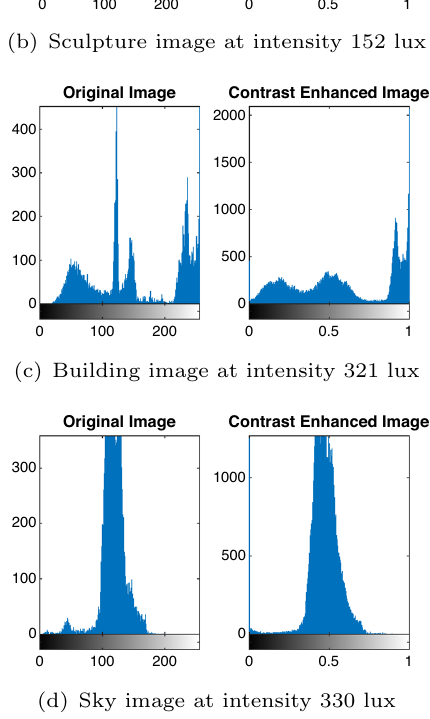
Figure 11. Histogram for the ground truth and contrast enhanced